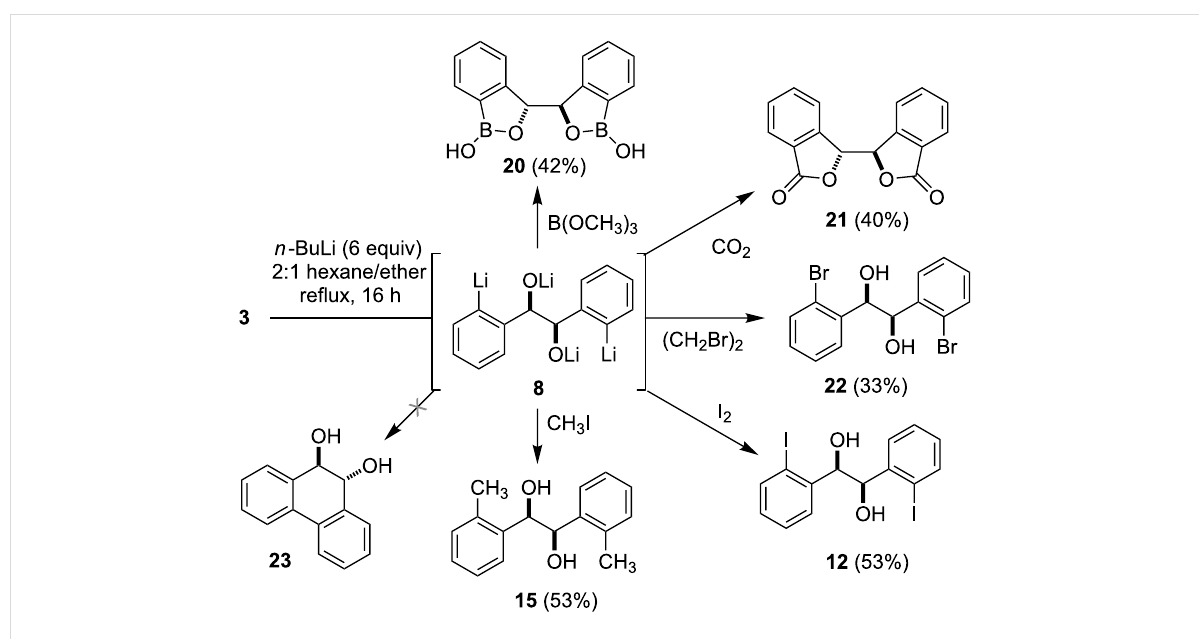
Scheme 3: Reaction of the tetralithio intermediate 8 with various